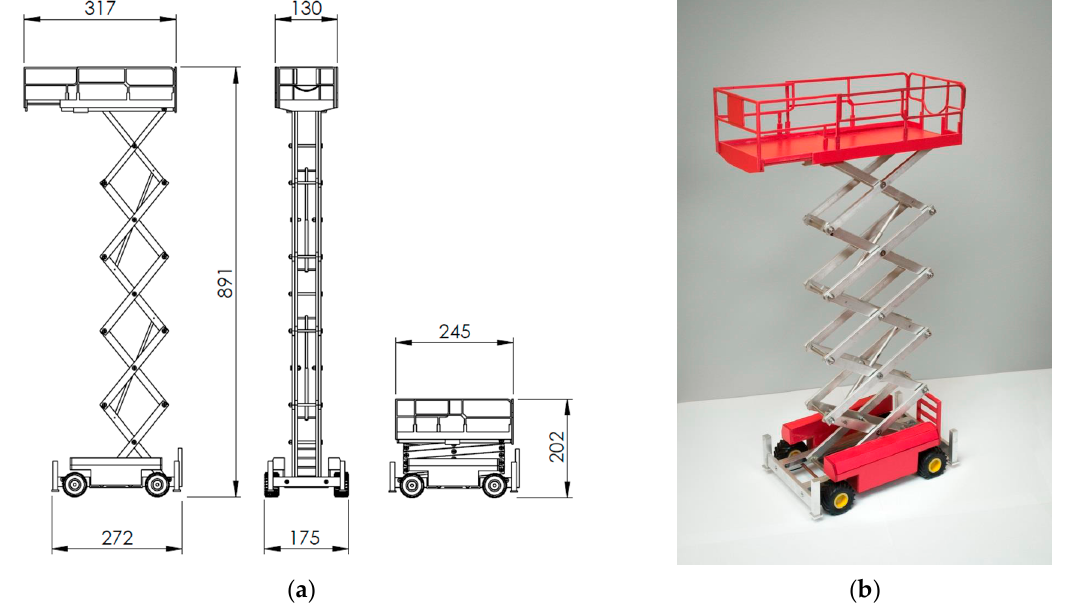
Figure 2. The model of the scissor lift (approximate scale 1:14): ( a ) The general geometrical dimension of the model, ( b ) the model in isometric projection.